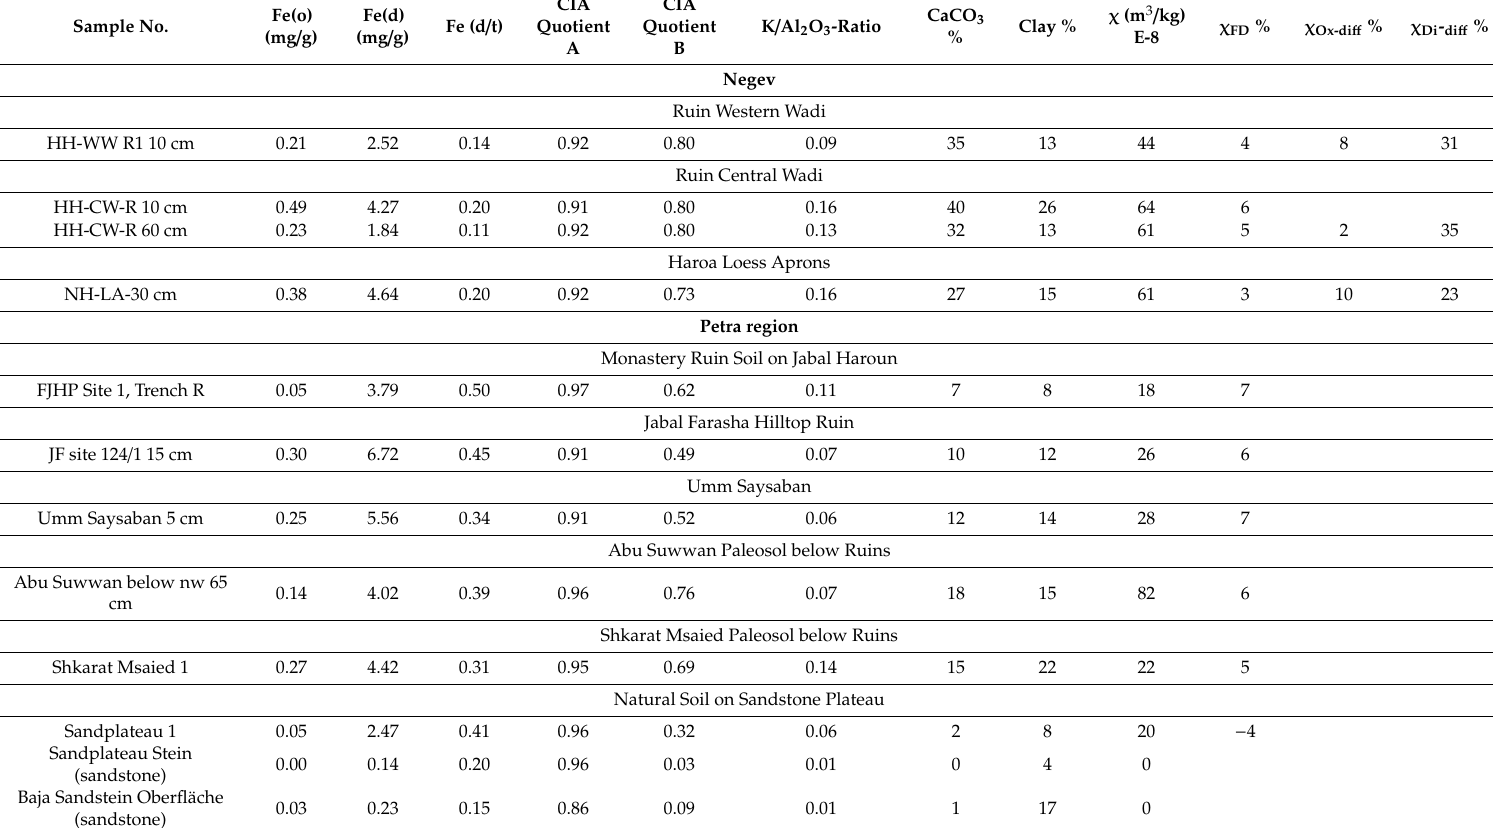
Table 8. Table summarizing indicators of pedogenesis for selected samples. For full results, see Table A5 in Appendix C. CIA refers to the index of chemical alteration according to [74]. χ is the weight-specific magnetic susceptibility, χ FD is the frequency-dependent change of susceptibility, χ Ox-di ff is the change of susceptibility after oxalate extraction, and χ Di-di ff after iron extraction with